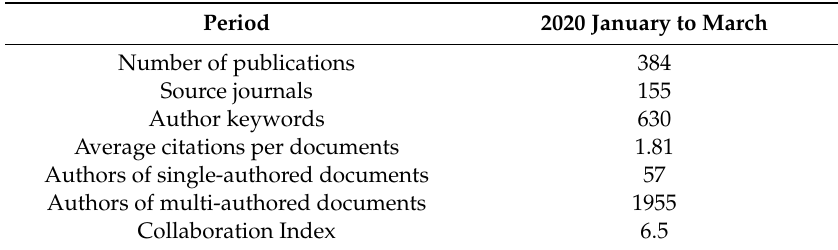
Table 12. Key information of the 2020 literature search.